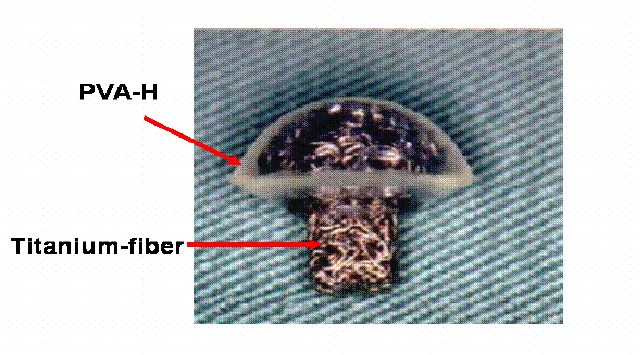
Figure 12. Photograph of a synthetic composite osteochondral device for partial replacement of the canine femoral head. The transparent portion is made of